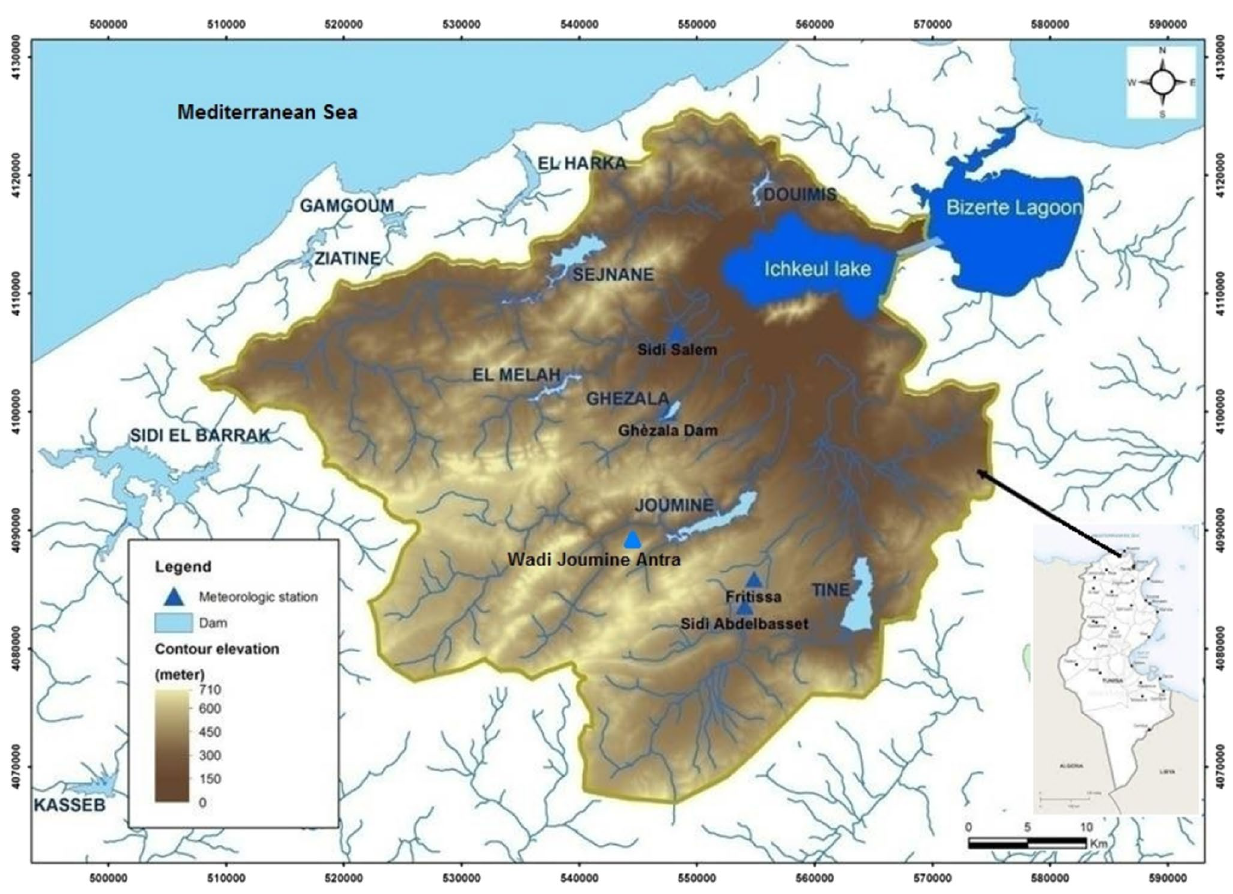
Fig. 1 Location of the Ichkeul lake basin. The studied rain gauges stations are shown on this map